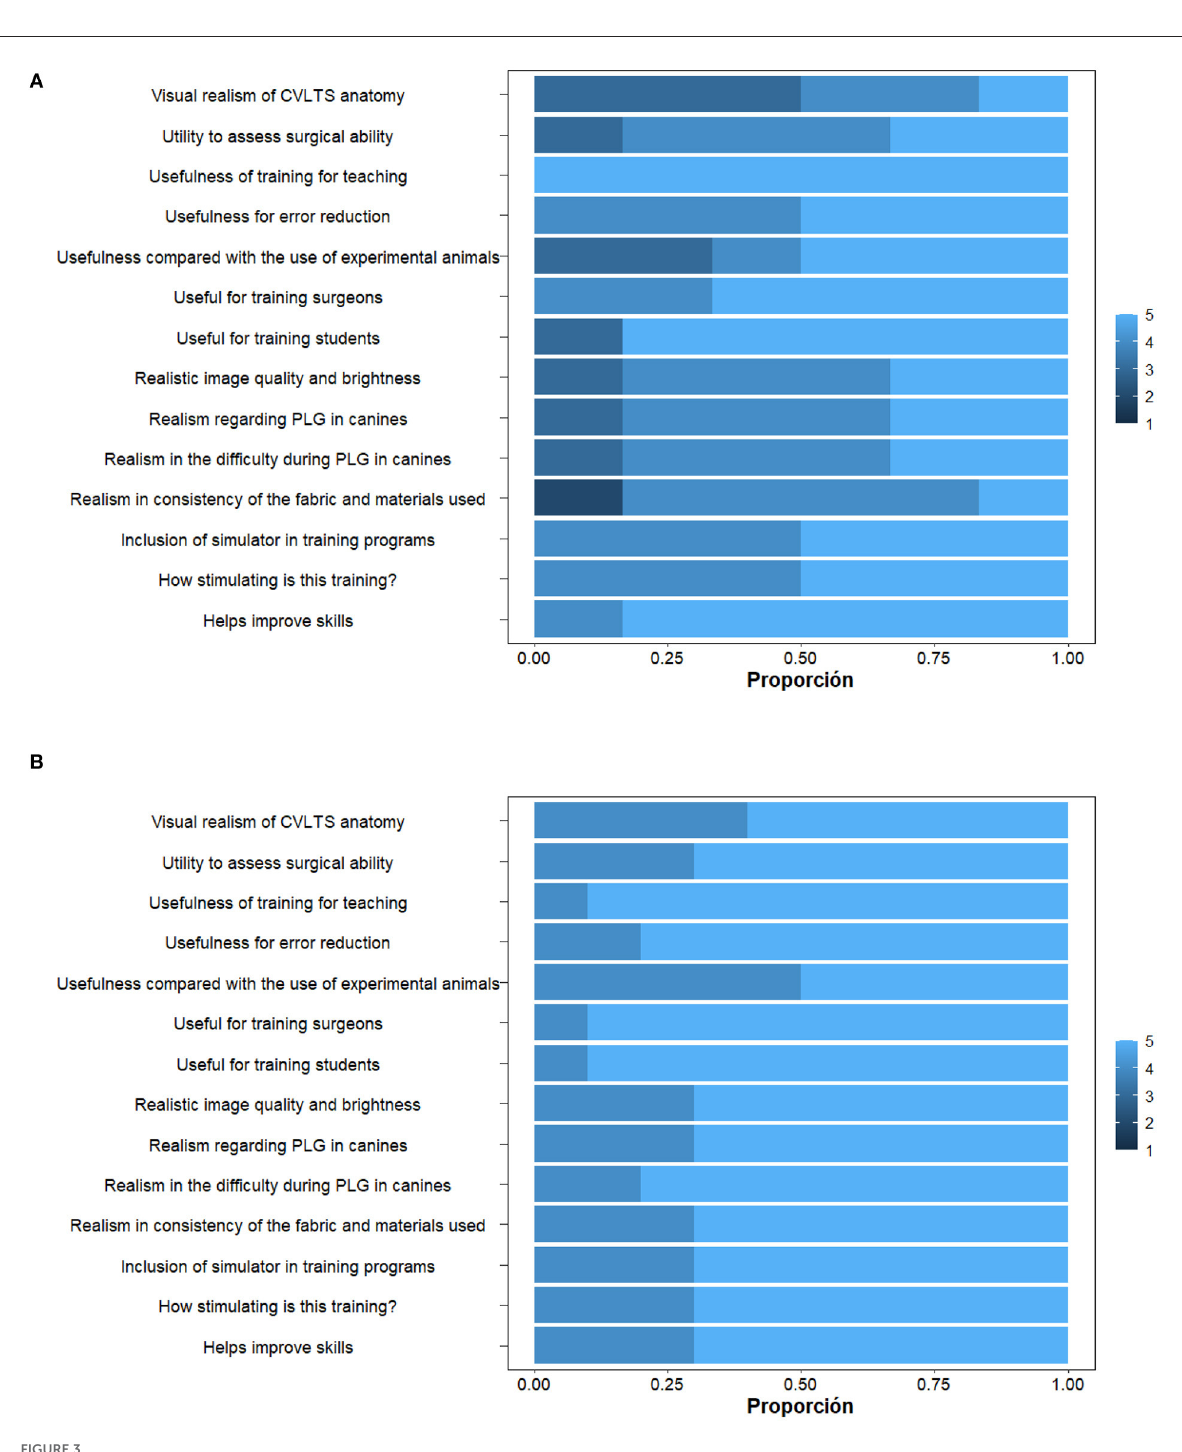
the range of motion of that limb, but it was not enough. Therefore, a larger and less rigid silicone port will be placed in the access point of the left hand (left portal) that allows